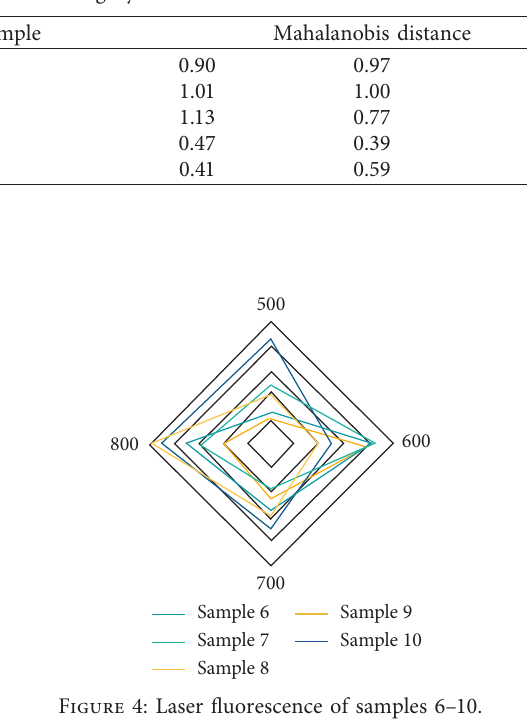
Table 1: Mahalanobis distance from inkpad on different carriers to its actual category.